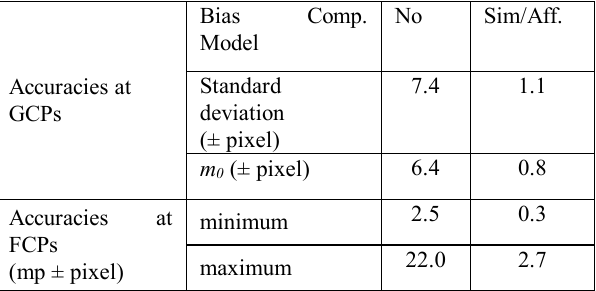
Table 2. Summary of the accuracies at GCPs and FCPs for 1st degree